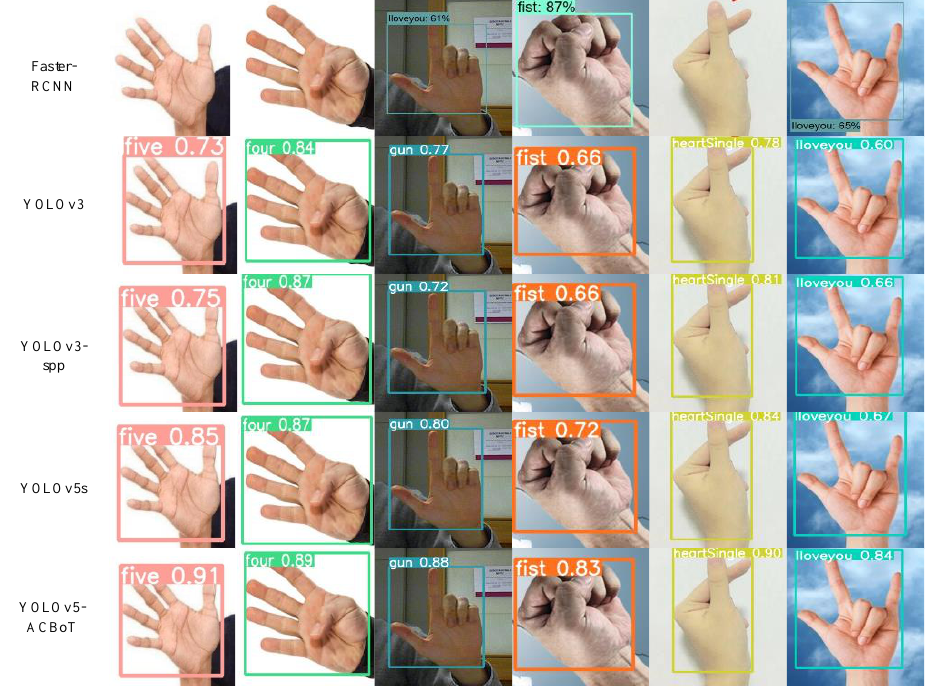
Figure 9. Four performance curves. ( a ) precision; ( b ) recall; ( c ) train-location-loss; ( d ) validation- location-loss.